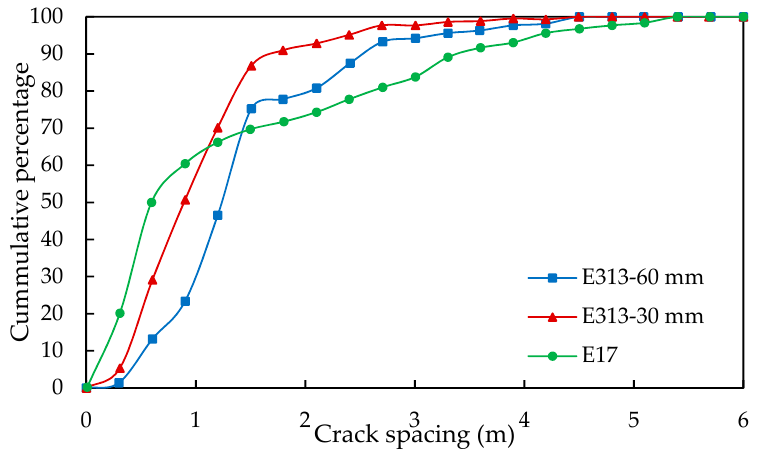
Figure 6. Comparison of cumulative crack spacing distribution between active crack control and passive crack control CRCP sections.